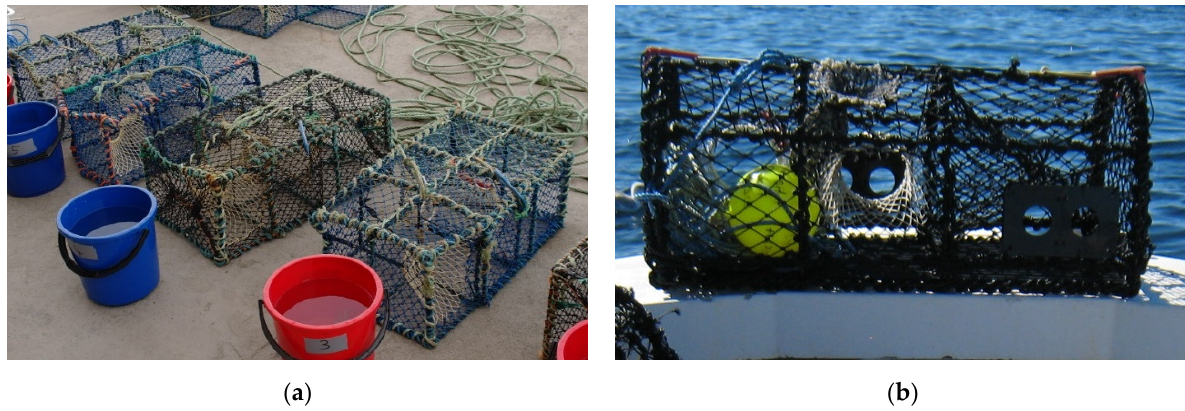
Figure 3. ( a ) Small cage type, with two entrances one on each long side (white funnel-shaped net); ( b ) lateral view of large cage type, with two entrances, one on each long side (white funnel-shaped net). The yellow surface buoy and line are stored in the left chamber of the cage.